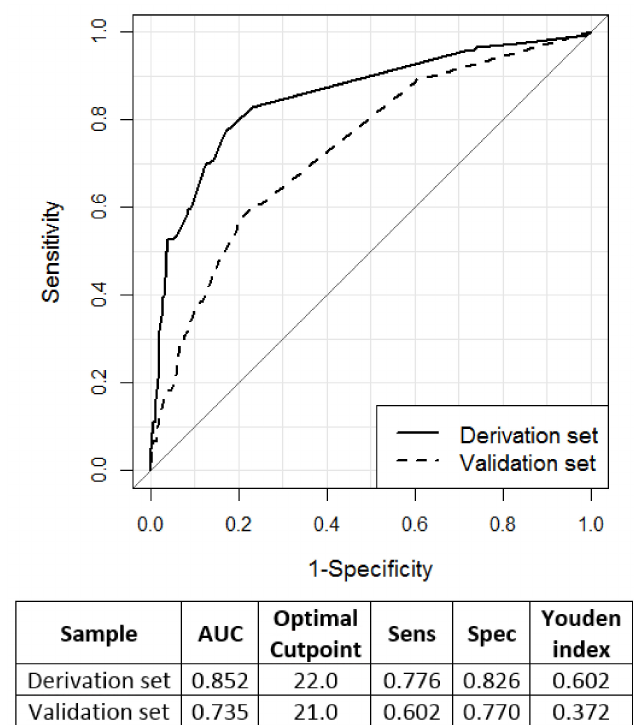
Figure 3. ROC curve showing the performance of CCI in identifying patients with e-LOS in the derivation and validation sets. The AUC values and the optimal cut-point identified by the Youden Index with the corresponding sensitivity and specificity are also